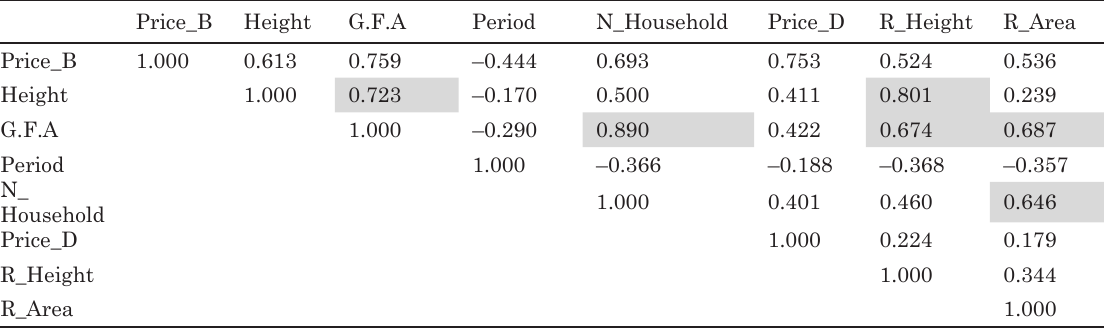
table 7. Correlation coefficients between building